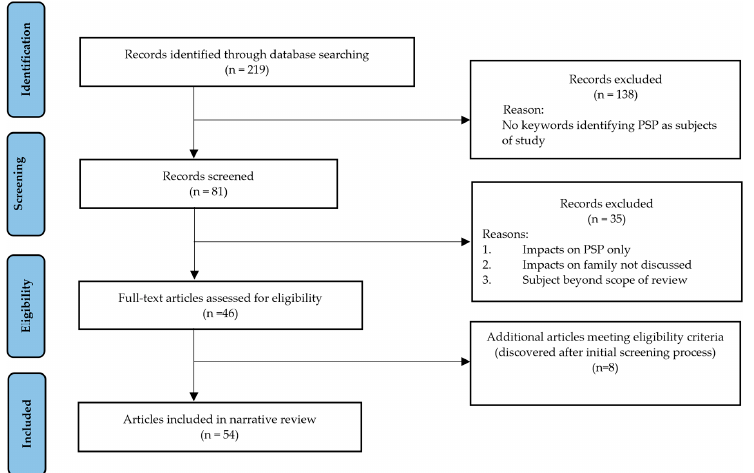
Figure 1. Diagram of narrative review search and article selection (adapted from PRISMA 2020 guidelines for systematic reviews) [34].